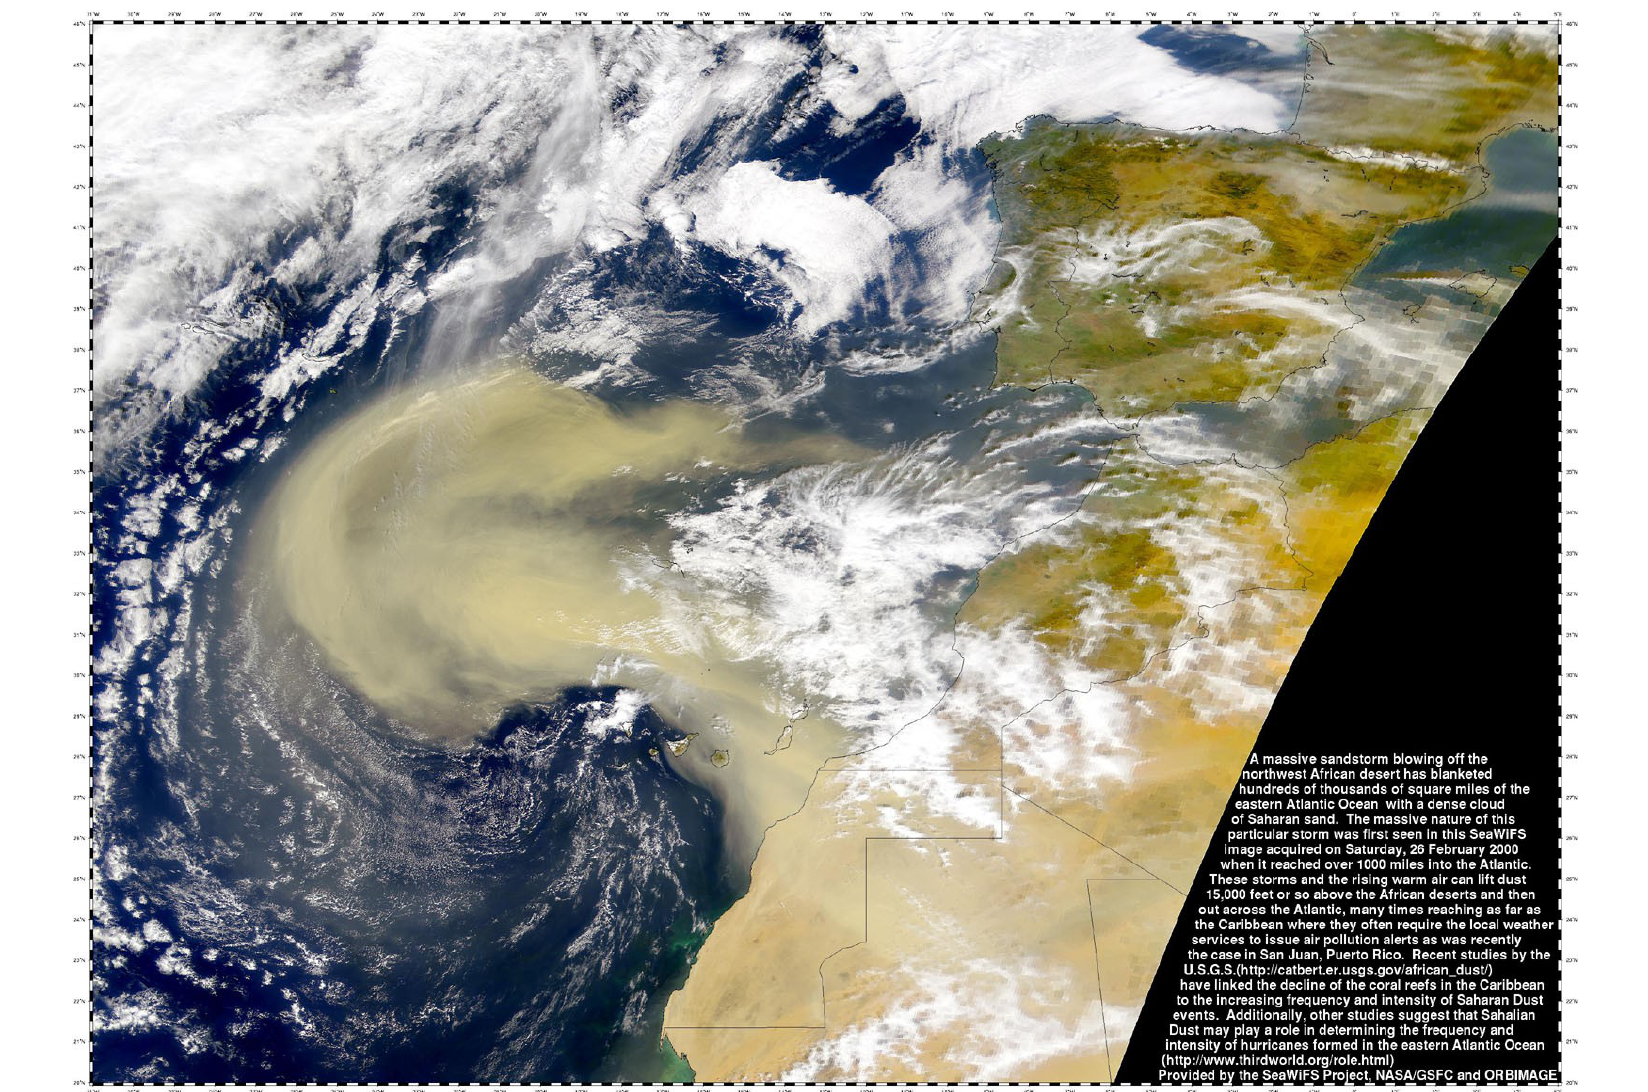
Figure 2. Cloud of sand from Africa being blown across the Atlantic Ocean